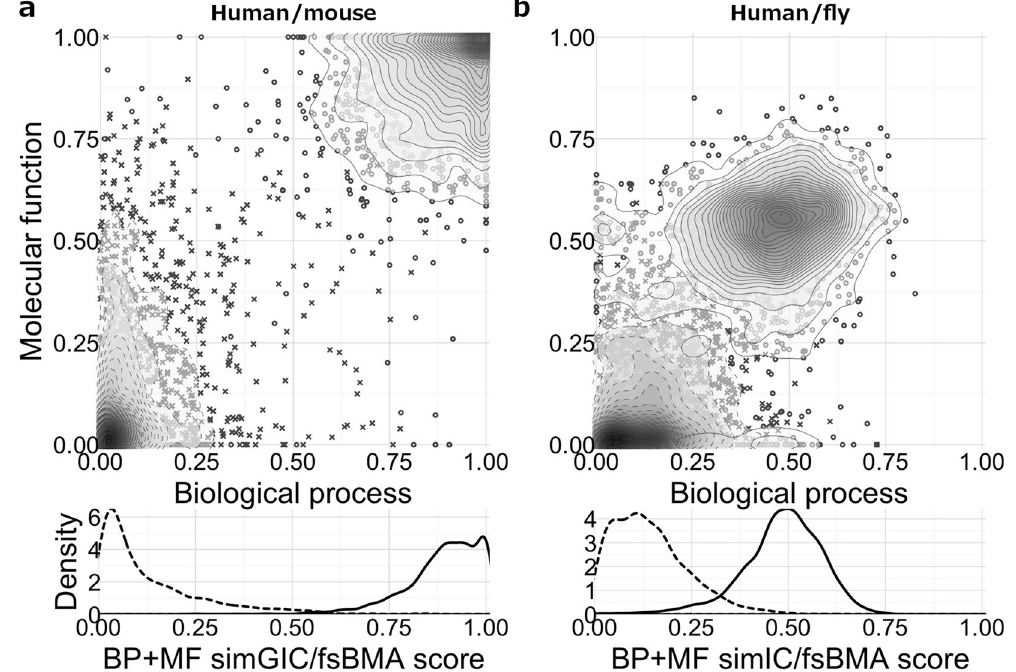
Figure 4. Distribution of BP, MF, and BP + MF combined FS scores (IEA ( + ) dataset) for selected orthologies. The upper part of the figure shows a scatter plot of BP ( x -axis) and MF ( y -axis) scores of orthologous gene pairs (cases, displayed as circles) and randomly selected gene pairs (controls, visualized as crosses) from the respective organisms. On top of this scatter plot the two-dimensional density function of these two distributions is displayed by solid and dashed iso-lines for cases and controls, respectively. Each two-dimensional point in this scatter plot is mapped to a real value by the F BP + MF function, which is the root mean square of the two individual scores. In the bottom part of the figure we show the one-dimensional density function of the so- computed F BP + MF scores for cases and controls using the same line styles as above. The crossing point of the two density graphs defines the optimal threshold for minimizing the error rate. ( a ) Human/mouse orthologues and controls with their associated simGIC / fsBMA scores. The simGIC semantic similarity in conjunction with the F BP + MF function greatly separates cases from controls, with an error rate of only 1.24%. ( b ) Human/fly orthologues and controls with their associated simIC / fsBMA scores. On average, we find 207.28 (CI = [205.86, 208.69]) incorrectly assigned pairs out of 1868 cases and 1868 controls, which corresponds to an error rate of